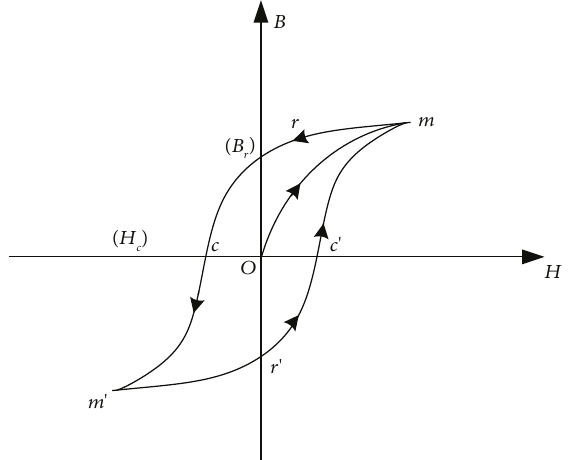
Figure 3: Schematic diagram of hysteresis